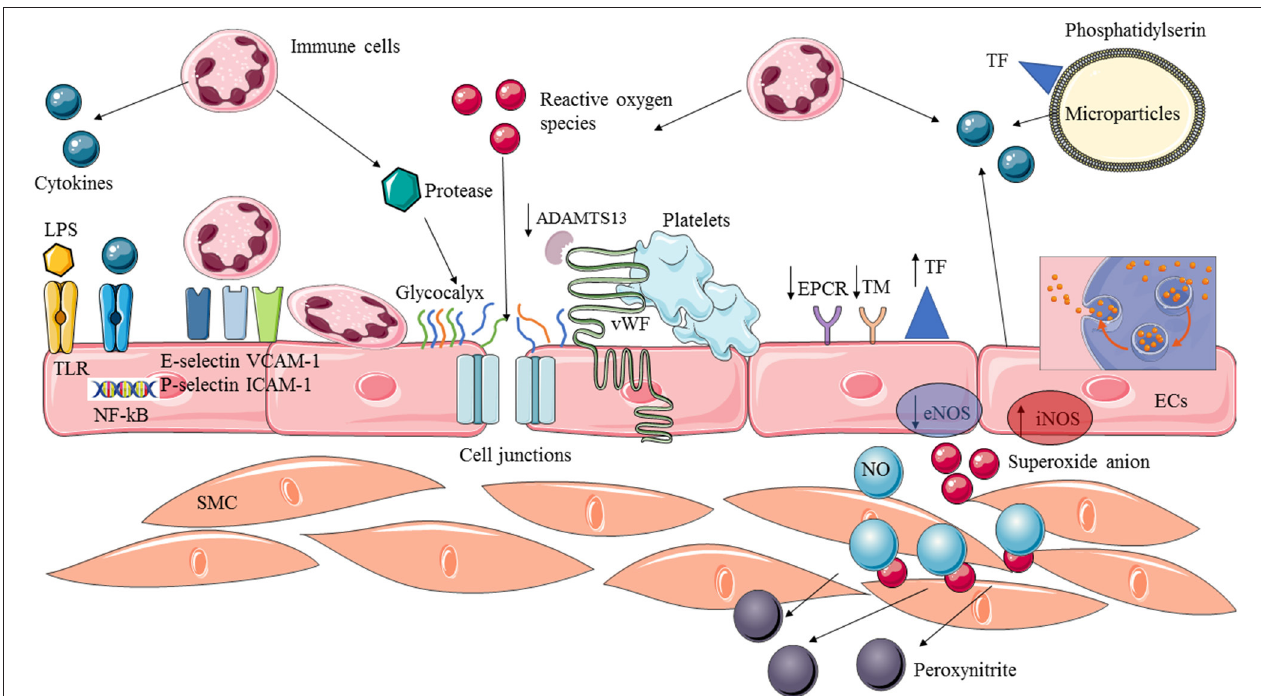
FIGURE 1 | Endothelial activation and dysfunction in sepsis. Endothelial cells are provided with membrane receptors (ex:TLRs) and can be activated by various stimuli factors such as microbial components (LPS) or pro-inflammatory cytokines. The recognition of circulating stimuli leads to the activation of NF-kB transcription factor allowing expression of adhesion molecules and switch to a pro-inflammatory and pro-coagulant phenotype. Circulating leukocytes are recruited, adhere to the endothelium and extravasate into the tissue. Pro-coagulant protein are overexpressed whereas anticoagulant and profibrinolytic proteins are downregulated. Cytokines, ROS and protease released by activated immune cells can cause structural damage, leading to an increased permeability and exposition of endothelial-derived proteins. Vasoreactivity is impaired by (1) decreased production of NO by the eNOS, and (2) complexed available NO with superoxide anion to produce peroxynitrite. Moreover, ECs play a crucial role in spreading the inflammatory reaction which, in turn, produces cytokines and free radicals, and the release of microparticles. ADAMTS13, A disintegrin and metalloprotease with thrombospondin type I repeats-13; ECs, Endothelial cells; SMC, Smooth muscular cells; TF, Tissue factor; TM, Thrombomodulin; EPCR, Endothelial protein C receptor; vWF, Von Willebrand factor; LPS, Lipopolysaccharide; TLR, Toll like receptor; eNOS, Endothelial nitric oxide synthase; iNOS, Inducible nitric oxide synthase; NO, Nitric oxide; ICAM, Intercellular adhesion molecules; VCAM, Vascular cells adhesion molecules; NF-kB, Nuclear factor of k-chain of